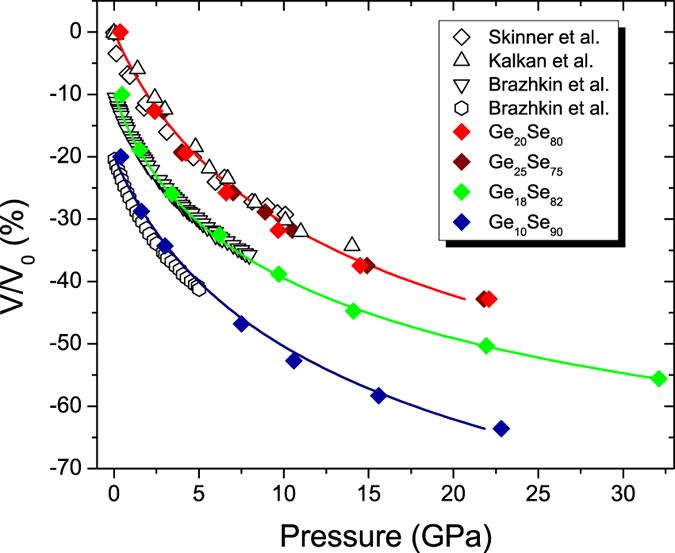
The pressure-volume equation of state for amorphous GexSe100−x.The results obtained by AIMD (filled diamond symbols) are compared to the measured data of Ge20Se80 of Kalkan et al.8 and Skinner et al.23, Ge17Se83 and Ge8Se92 of Brazhkin et al.29 (open symbols). The solid lines represent third-order Birch-Murnaghan equation of state fits to the simulation data. Numerical and experimental data of Ge18Se82 and Ge10Se90 have been shifted by multiples of −10% for clarity.